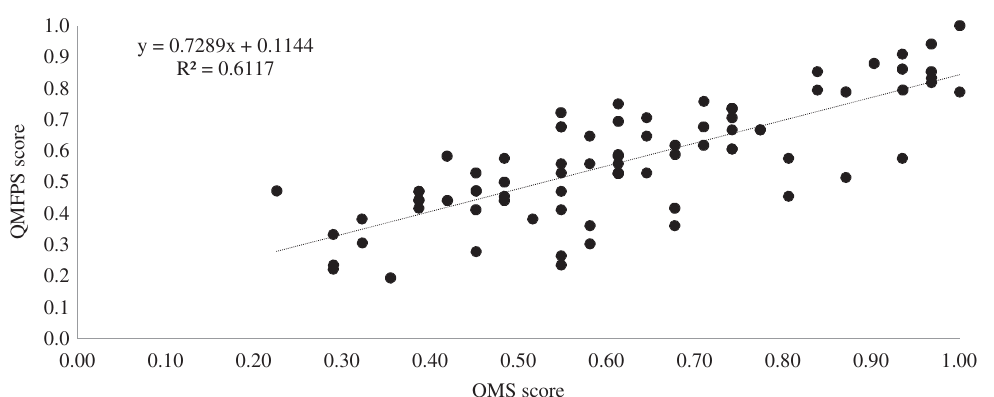
FIG. 2. Correlation between 82 students ’ QMFPS scores and their QMS scores. The coefficient of determination is R 2 and the correlation coefficient is R ¼ 0 . 78